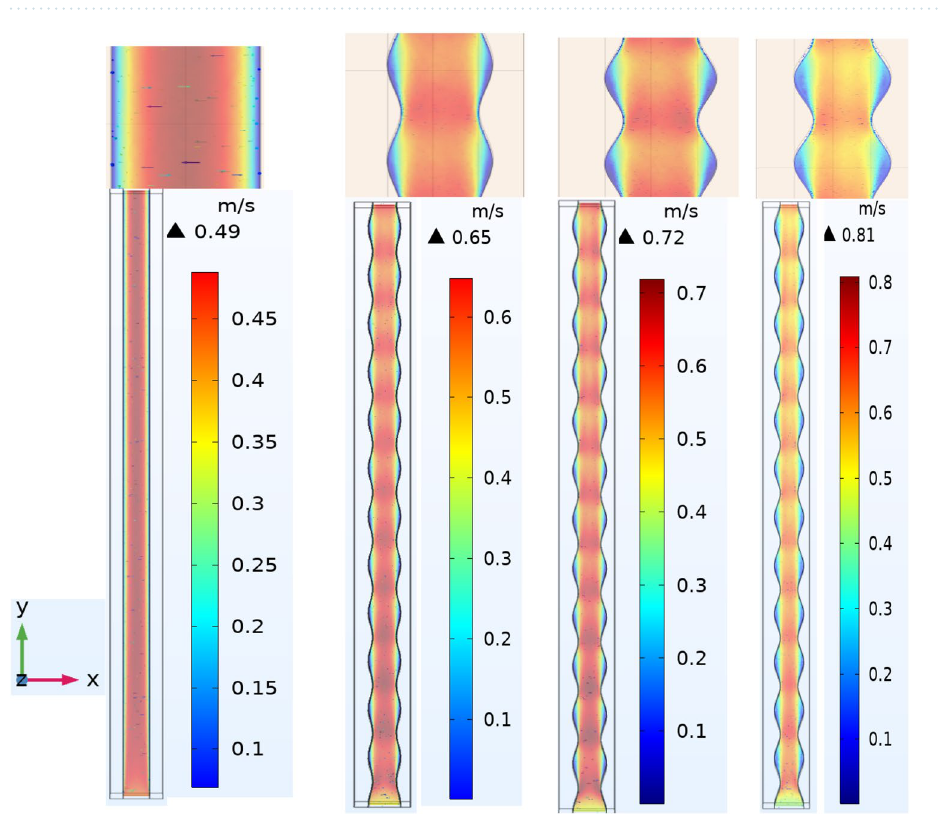
Figure 9. Effect of corrugtion walls on velocity magnitude at φ = 0.075, Re = 800, q_w = 180 kw/m 2 for amplitude (A) = 0, 0.15, 0.2 and